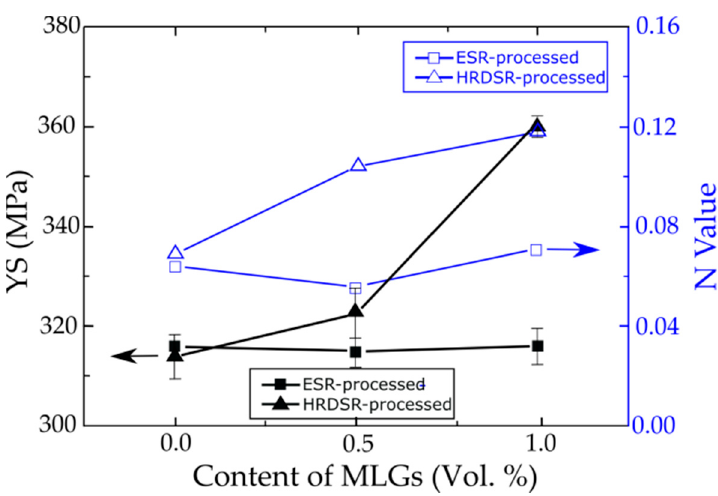
Figure 21. YS and N values versus MLG contents for the ESR- and HRDSR-processed Cu composites [93]. Reproduced with permission from Kim et al., Carbon ; published by Elsevier, 2014.